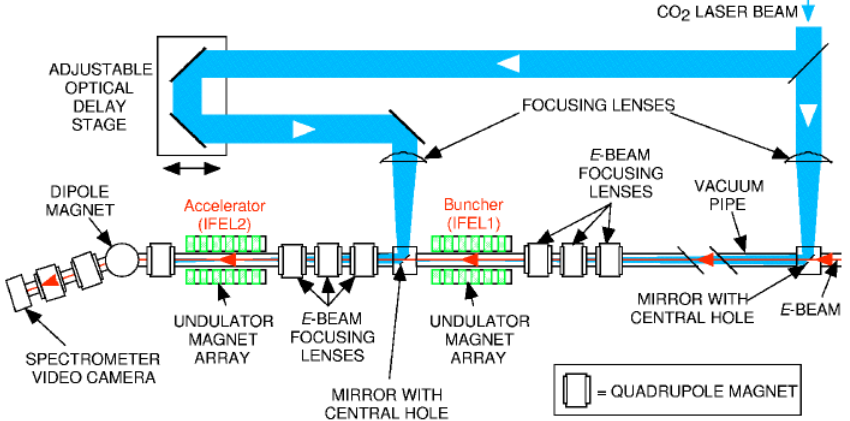
FIG. 1. (Color) Schematic layout for the STELLA